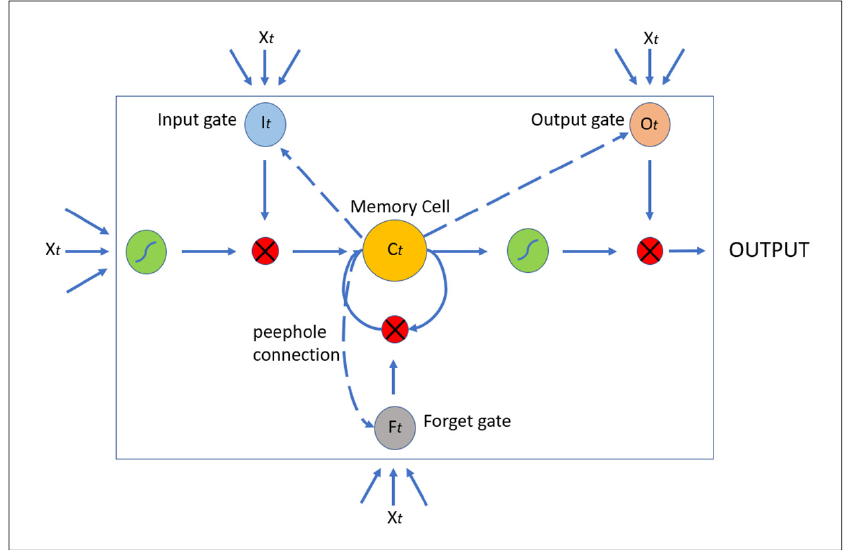
Figure 10. Basic conceptualisation of an LSTM unit where Xt represents the input vector at time t. It, Ot, Ft, and Ct represent the input gate, output gate, forget gate, and core memory cell, respectively. Blue arrows indicate directional information flow. Dotted blue arrows indicate peephole connections. This illustration is based on the illustration of an LSTM unit in Figure 5 depicted in Lyu et al. [34].